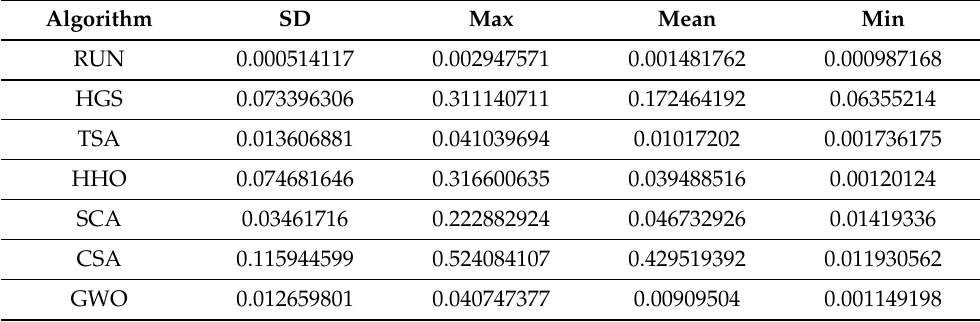
Table 7. DDSCM statistical analysis.